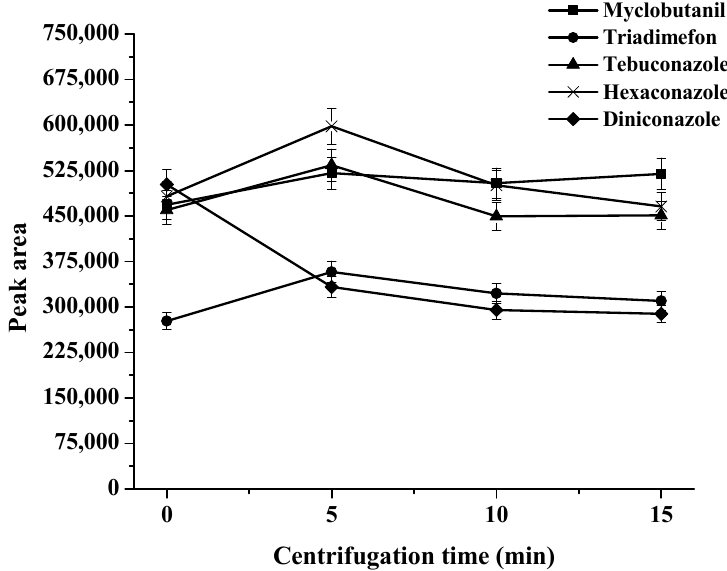
Figure 7. Effect of centrifugation time on extraction efficiency.